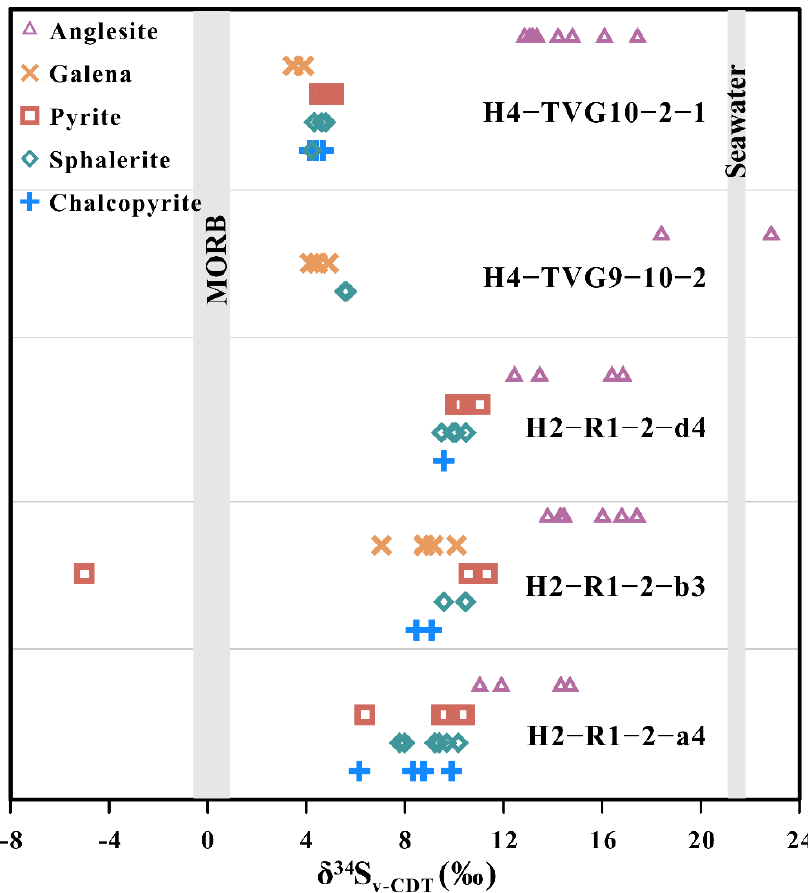
Figure 10. Sulfur isotope values for anglesite and sulfide minerals from the MOT and SOT hydrothermal sulfide deposits. MORB data from Sakai et al. [63], Alt et al. [64], Shanks et al. [65] and Alt and Shanks [66]. Seawater data from Rees et al. [67].